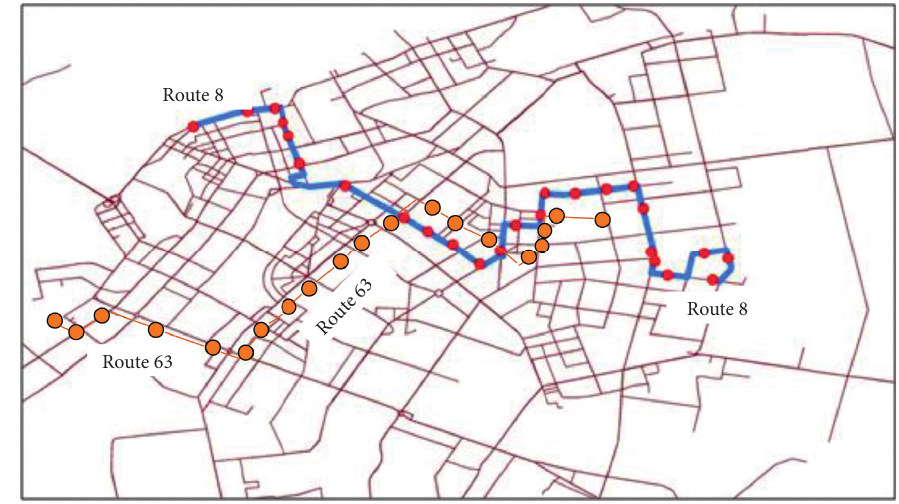
Figure 1: Spatial distribution of bus stop on Route 8 and Route